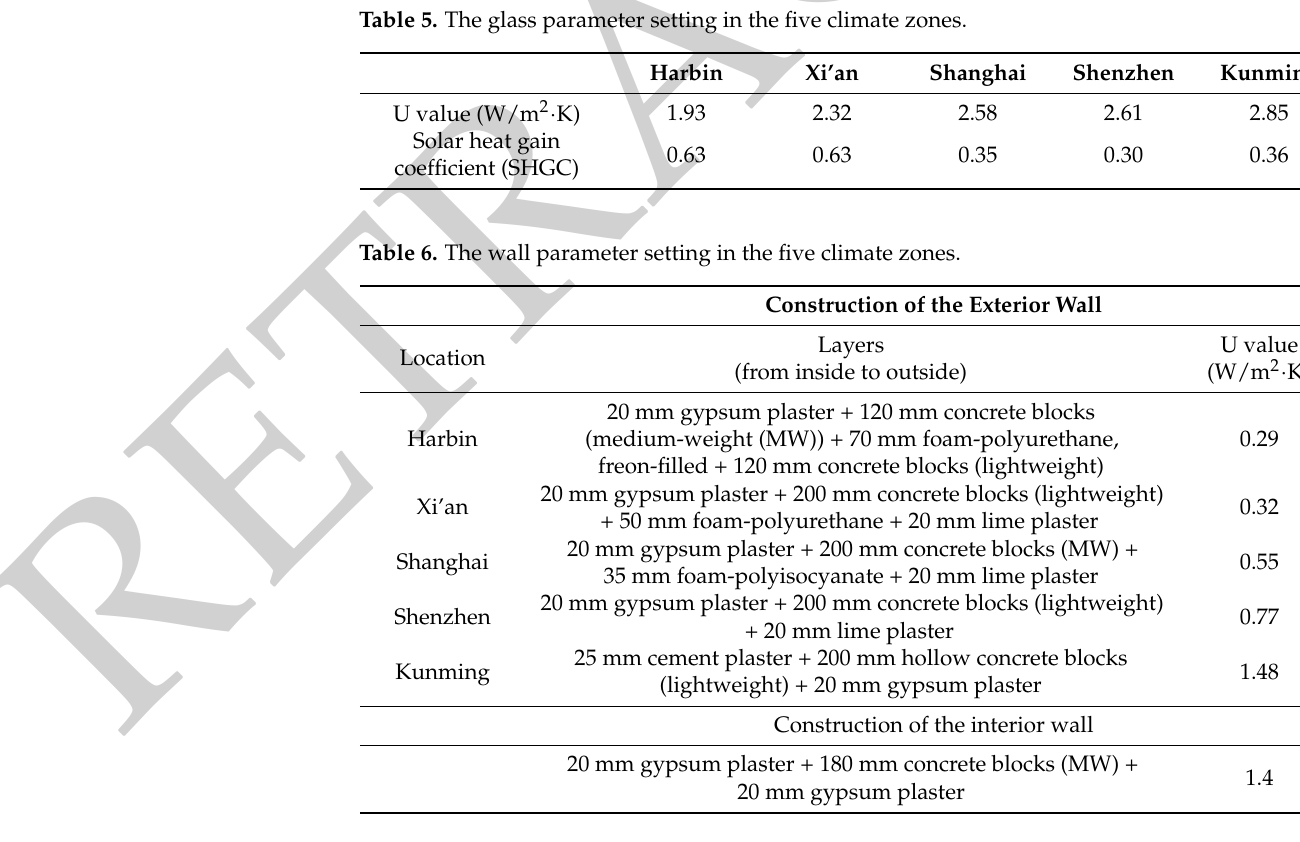
Table 5. The glass parameter setting in the five climate zones.